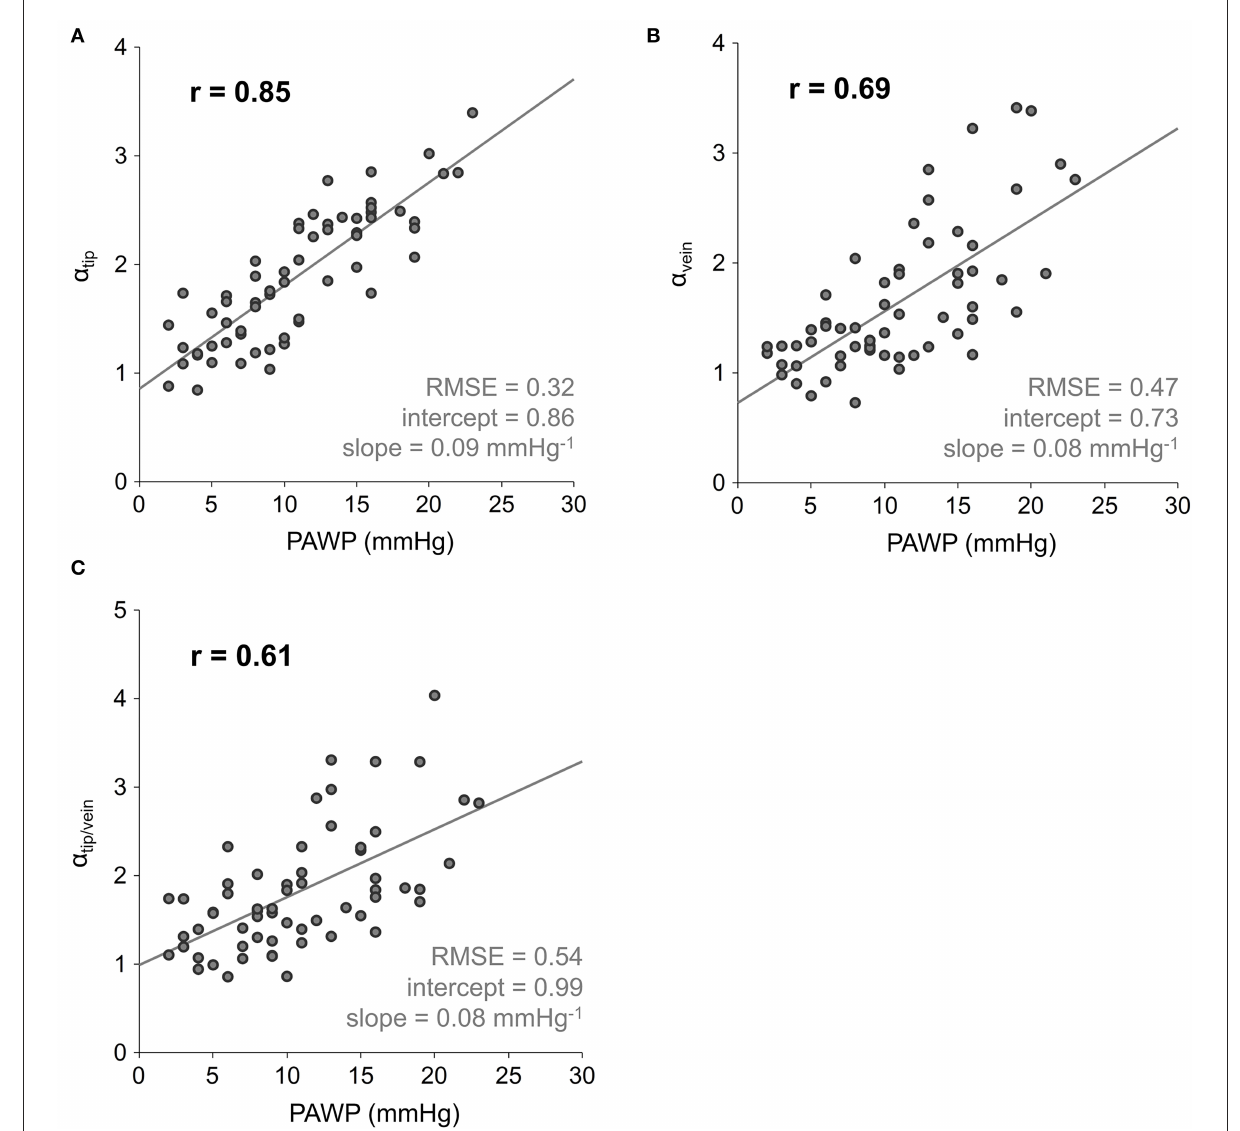
FIGURE5 Scatter plots and linear regressions of the LA acceleration factors on PAWP, with LA acceleration factors calculated from peak velocity measurements at the level of mitral valve tips α tip (A) , within the pulmonary vein α vein (B) , and both α tip / vein (C) . PAWP, mean pulmonary artery wedge pressure; r, correlation coefficient; RMSE, root-mean-square